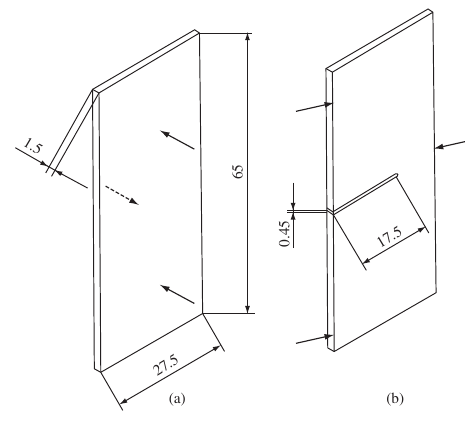
Figure 2. Tablet-shape test specimens: a) Un-notched for quasi-static transversal 3PB test; and b) Notched for 3PB translaminar impact testing. Dimensions are in